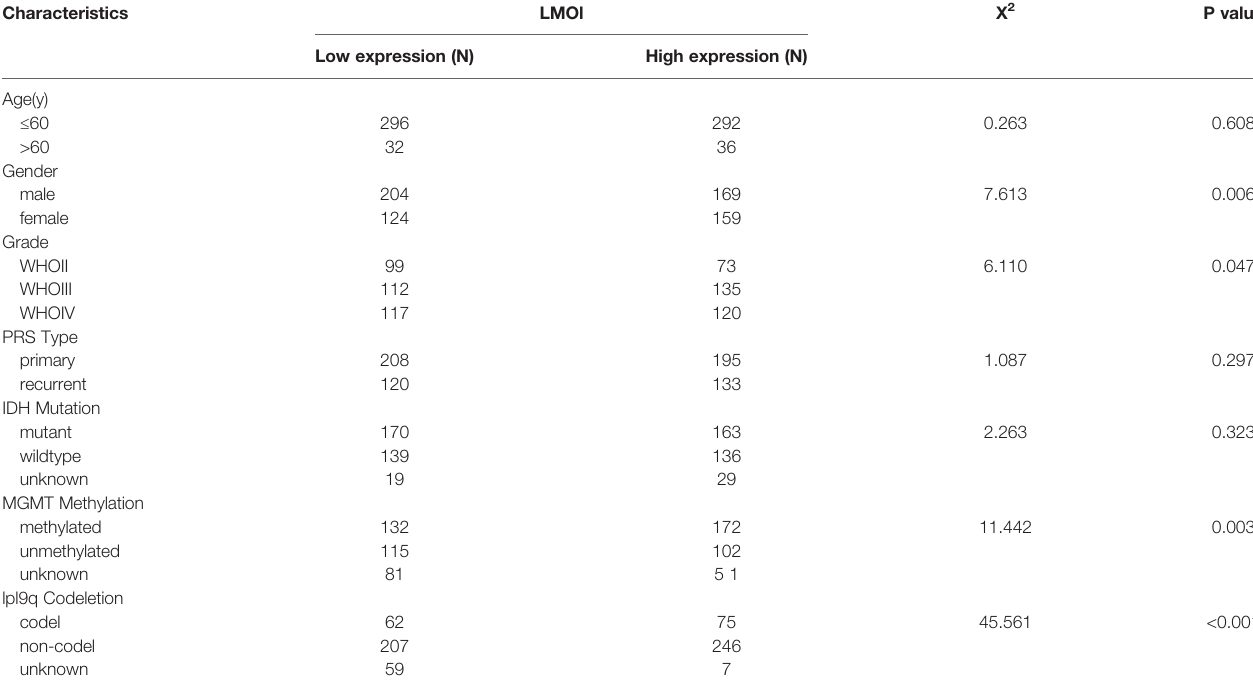
TABLE 1 | Relationship between LMOl expression and clinicopathological Characteristics of GBM patients based on CGGA (n = 656). Characteristics LMOl X